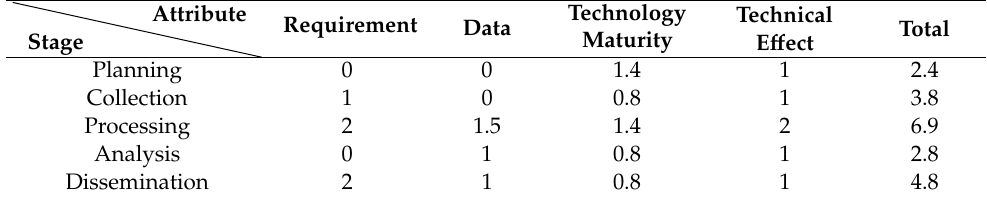
Table 6. Priority-determination results obtained upon applying the AI technology to the military intelligence areas.